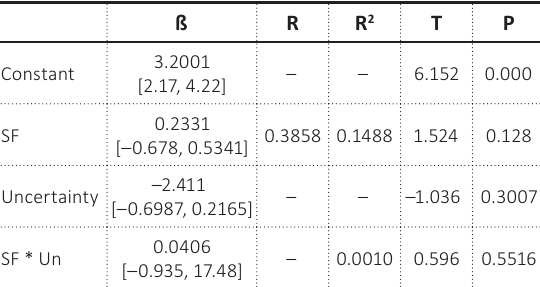
Table 4. Regression analysis of different SF dimensions: Performance dimensions